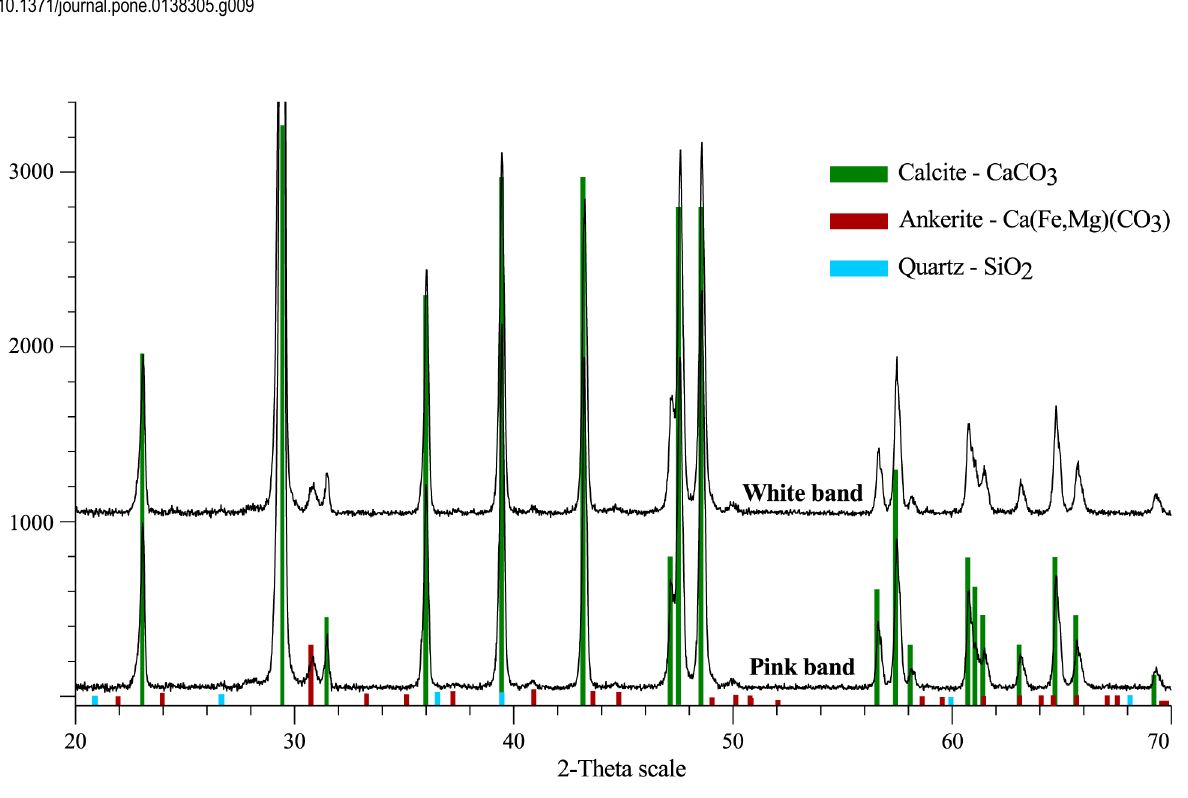
Fig 10. X-ray diffraction spectra of the white and pink bands of UOM-232. Both bands have the same mineralogical composition of calcite with minimal amounts of quartz and ankerite.